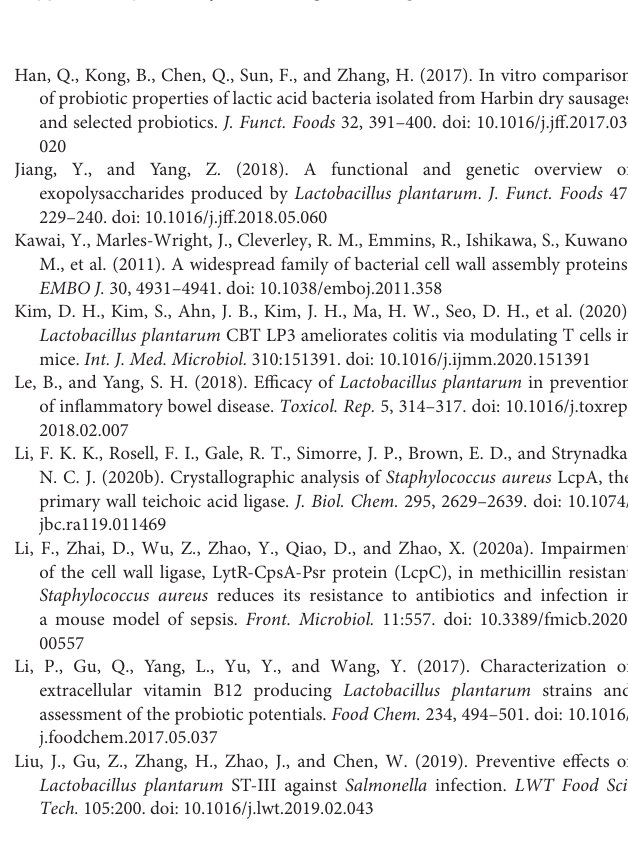
Supplementary Figure 1 | The proposed EPS biosynthesis pathway for the cpsWc gene cluster. Supplementary Figure 2 | Copy number change of pYZ1 during serial passage at different temperatures. The wild-type LTC-113 strain was culture at 30 ◦ C, 37 ◦ C, and 43 ◦ C. The copy number of the plasmid pYZ1 was measured by qPCR. Supplementary Figure 3 | Transmission electron microscope analysis of LTC-113 and its derivatives. Supplementary Figure 4 | The supernatant EPS concentration curve in a 20-hrs time course. Supplementary Figure 5 | Analytical size-exclusion chromatography for EPS from LTC-113 and the pYZ1-cured strain. Supplementary Figure 6 | Adhesion inhibition of pathogenic E. coli by L. plantarum . The inhibitory activities of LTC-113 and its derivative strains on the adhesion of E. coli in three experimental models, including exclusion, competition, and displacement. Values represent mean ± SD of the mean; * P < 0.05; ** P < 0.01; *** P < 0.001. Supplementary Table 1 | Genomes, plasmids, and oligonucleotides used in this study. Supplementary Table 2 | CFU counting data for Figure 3 . Supplementary Table 3 | CFU counting data for Figure 4A . Supplementary Table 4 | CFU counting data for Figure 5